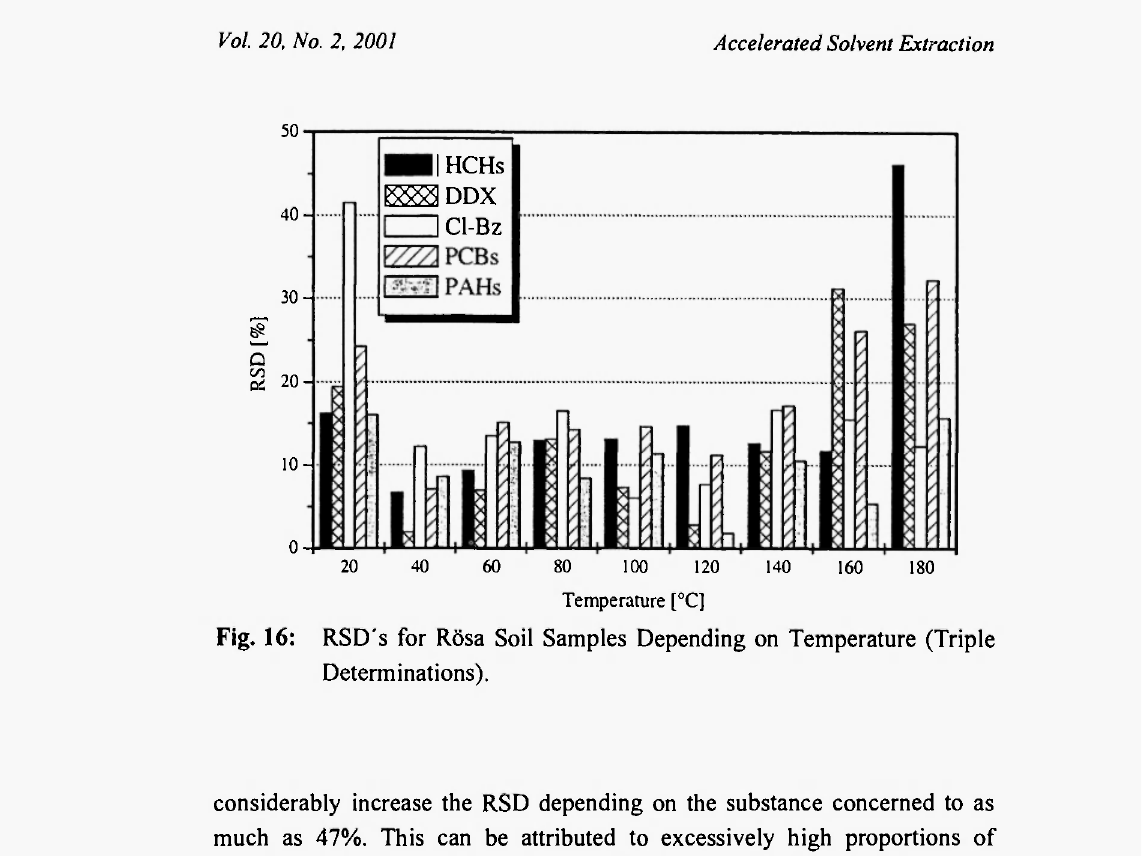
Fig. 16: RSD's for Rösa Soil Samples Depending on Temperature (Triple